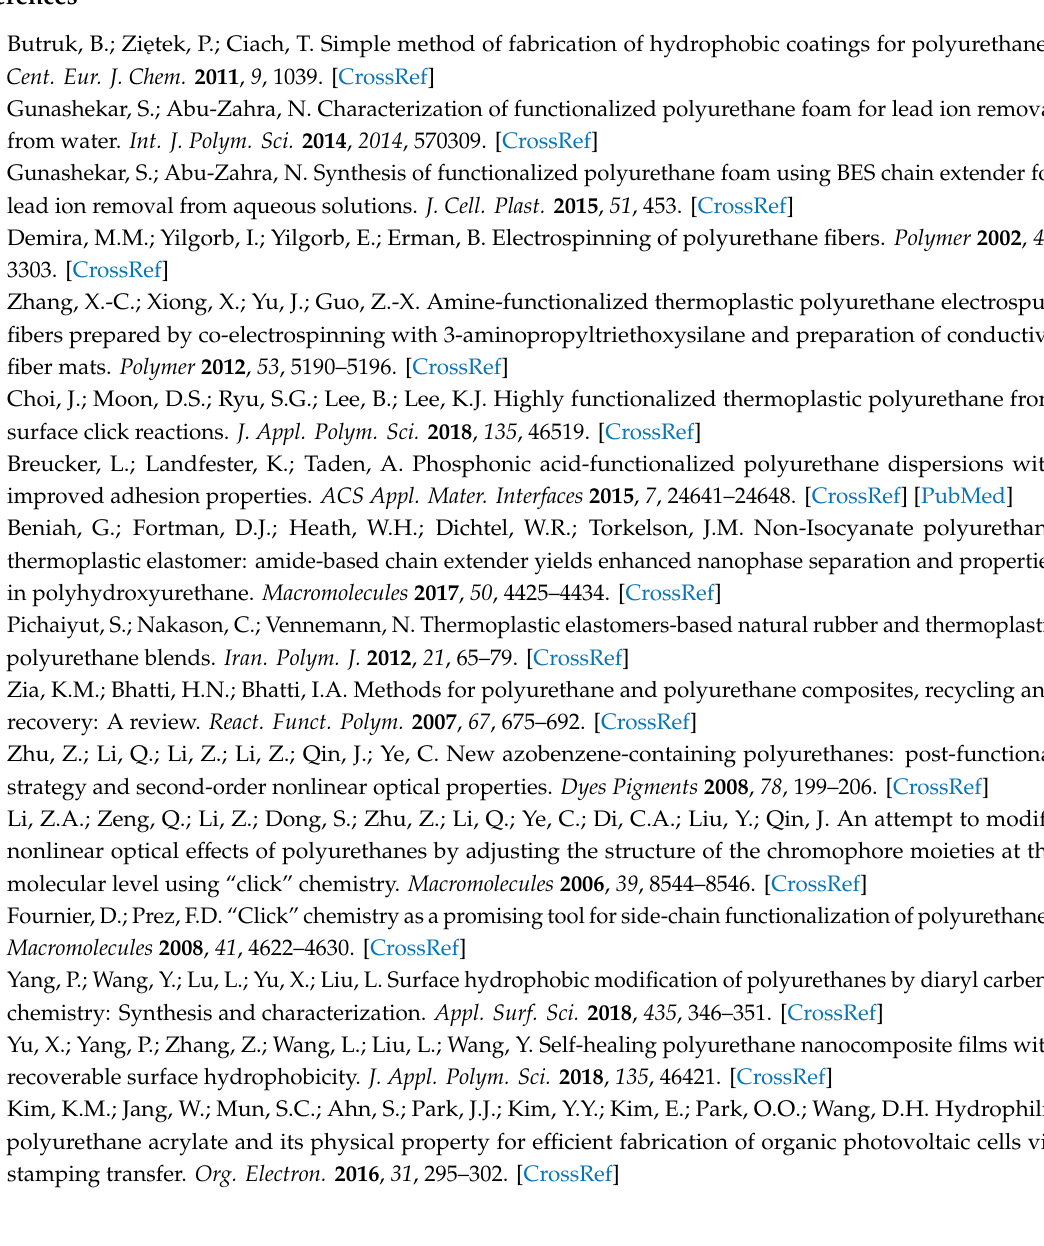
Table S1. Determined compositions of reaction mixtures in experiments on synthesis of linear polyurethanes; Table S2. Compositions of reaction mixtures in experiments on the synthesis of linear polyurethanes; Table S3. Compositions of the functionalization of linear polyurethanes; Table S4. Measured viscosities and T g values of polyurethanes; Table S5. Measured contact angles of di ff erent liquids for polyurethanes and Diels–Alder functionalized coatings; Table S6. Determined free surface energies for polyurethanes and Diels–Alder functionalized coatings; Figure S1. 1 H-NMR of maleimide STD; Figure S2. 1 H-NMR of PU06B; Figure S3. 1 H-NMR of